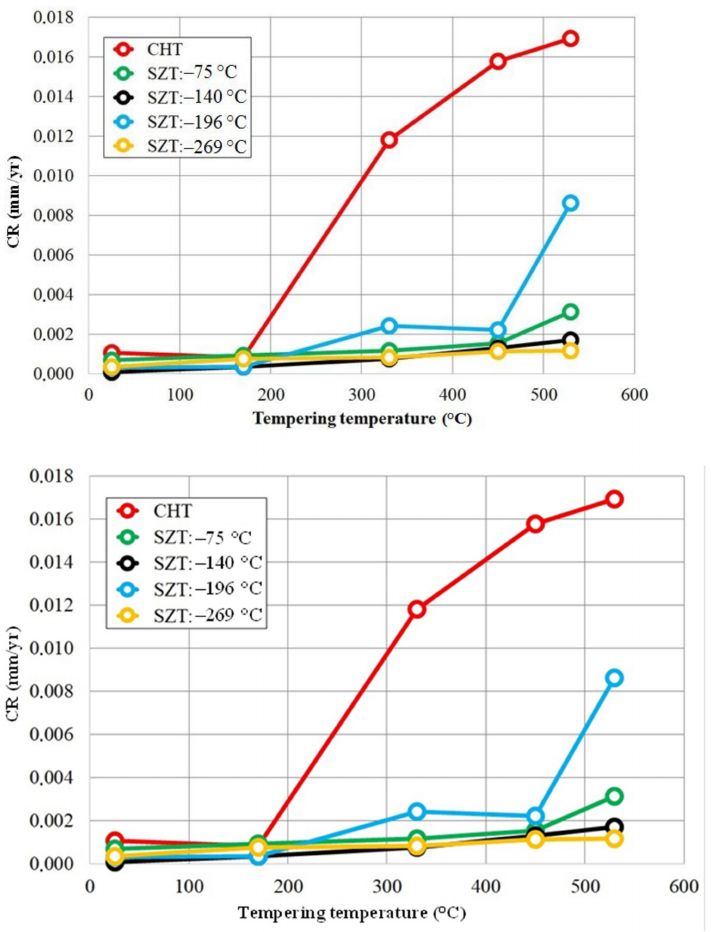
Figure 11. Corrosion rate in dependence on tempering temperature for CHT specimens and for specimens after application of different SZTs.